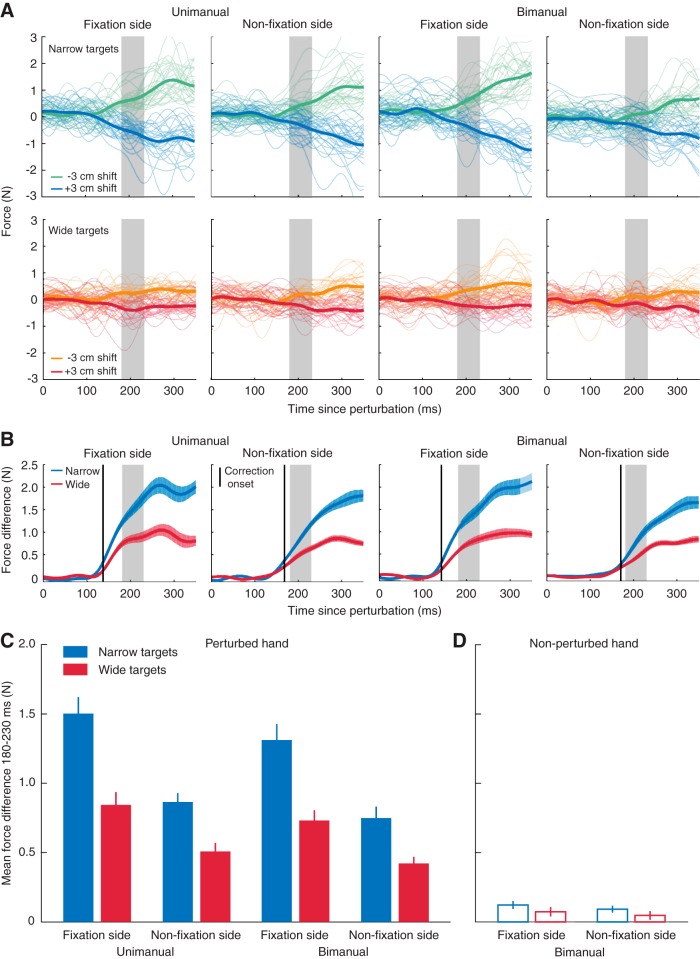
Visuomotor responses in experiment 1. (A) Raw forces measured in channel trials in response to a leftward (–3 cm; in green and orange) and rightward (3 cm; in blue and red) displacement of the visual cursor during reaches to narrow (top row) and wide targets (bottom row) of the same example participant as in Fig. 1. (B) Difference in force responses to leftward and rightward cursor perturbations during reaches to narrow (in blue) and wide targets (in red), averaged across participants. Blue and red shaded areas indicate ±1 SEM. The black vertical line indicates the average onset of the corrective response (see Methods). The gray shaded area indicates the 180- to 230-ms interval across which the force differences were averaged to obtain a single measure of the strength of the response. (C) Mean force differences averaged across the 180- to 230-ms interval following the cursor perturbation. Error bars represent ±1 SEM. (D) Mean force differences at the nonperturbed hand in bimanual conditions.